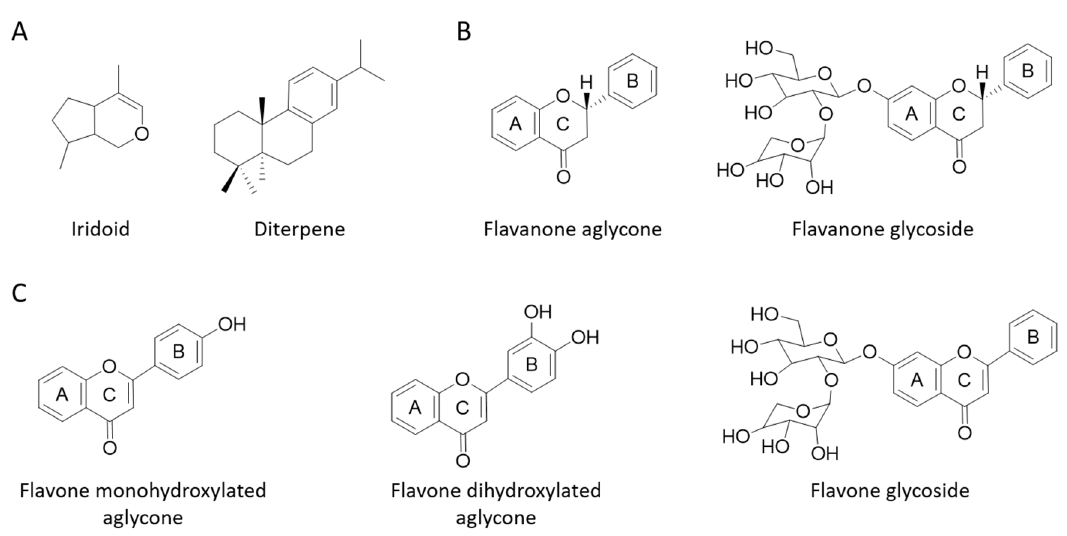
Figure 1. General structure of the phytocompounds families that were present in the studied formulations grouped into terpenes ( A ), flavanones ( B ), and flavones ( C